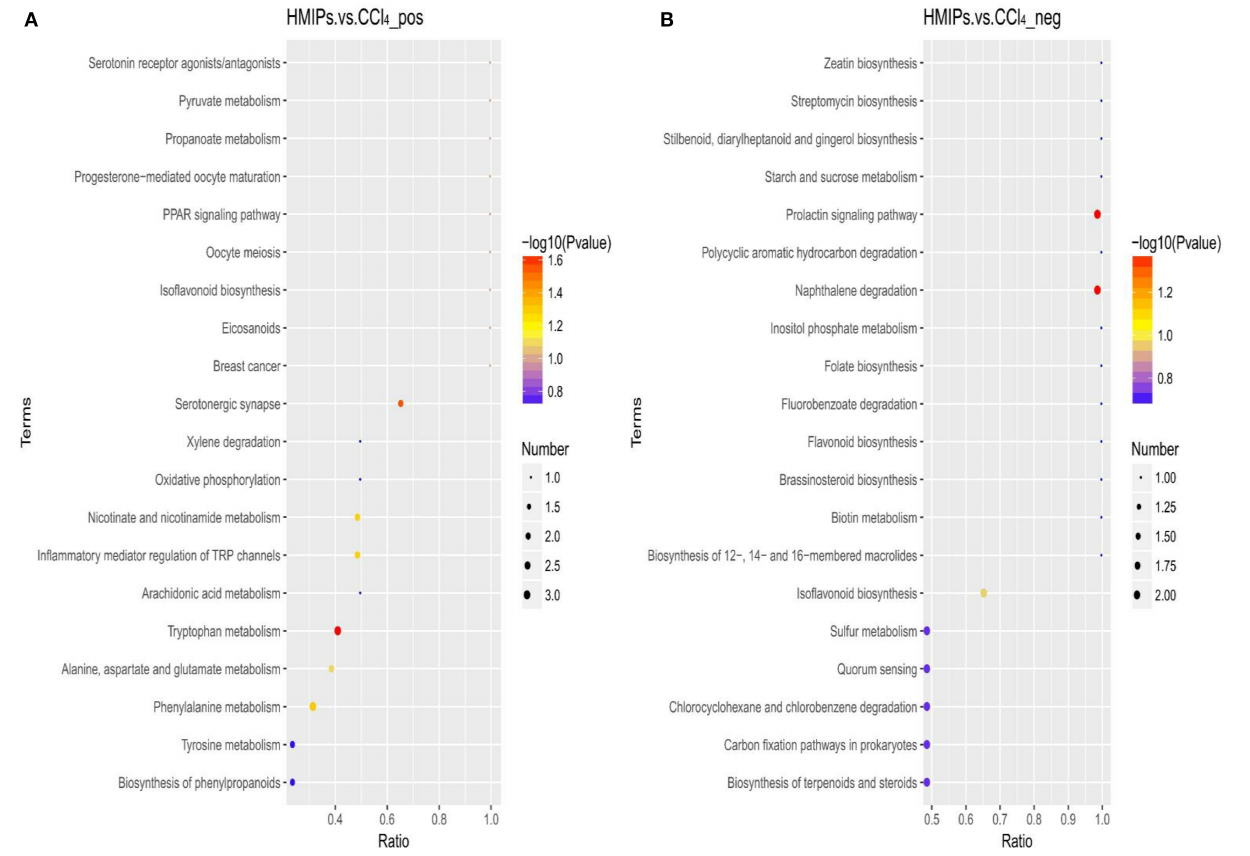
ratio of prunin between the HMIP and CCl 4 groups was